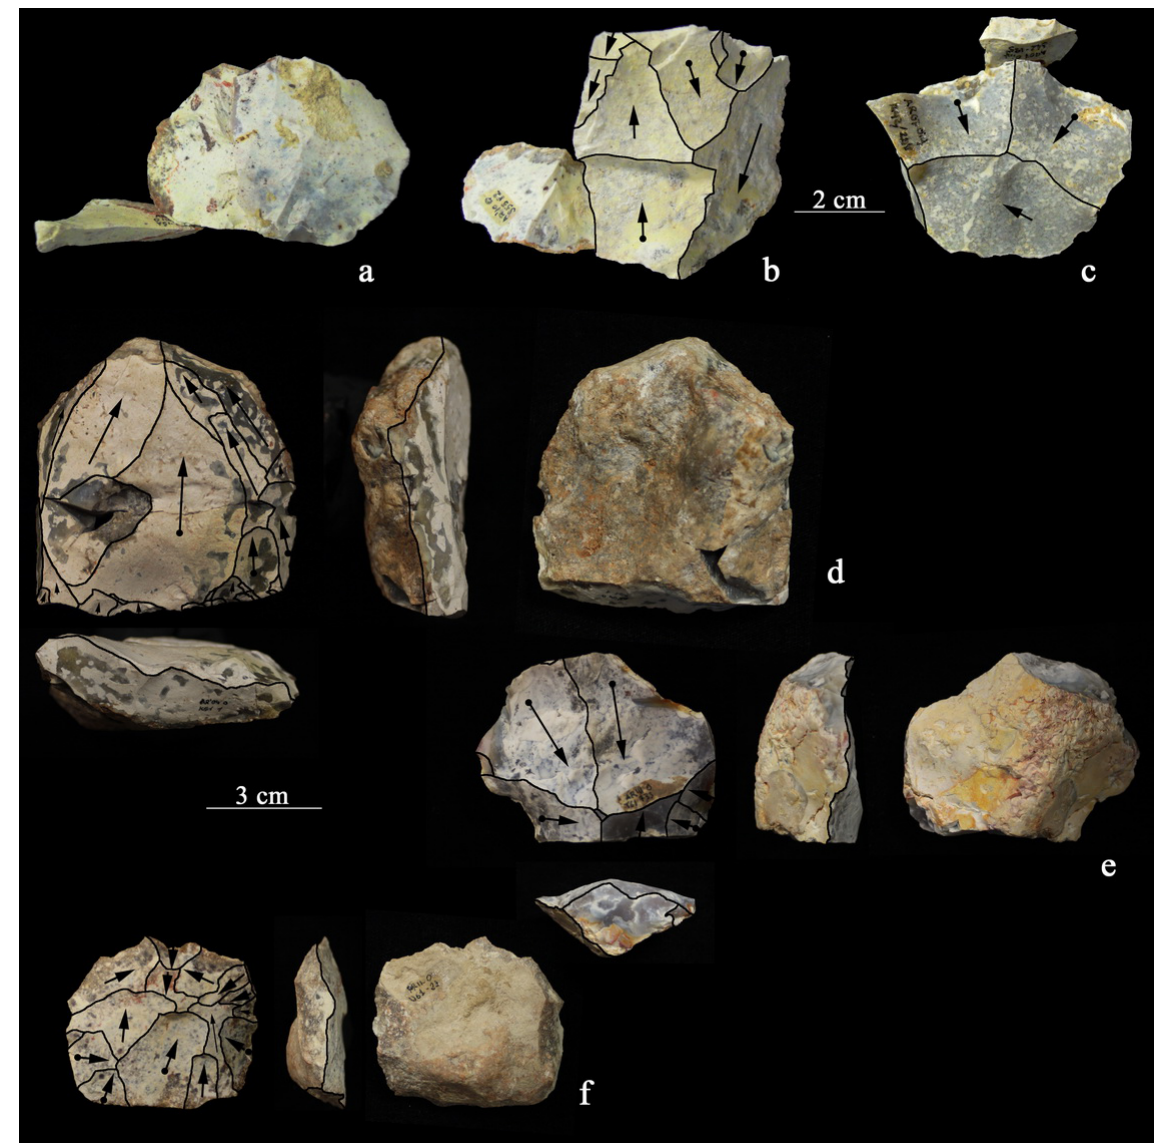
Figure 6. Layer O. (a, b, c): refits. Scale bar 2 cm. (d): Unipolar Levallois core for sub-triangular flake production; (e): centripetal Levallois core-on-flake; (f): centripetal Levallois core. Scale bar 3